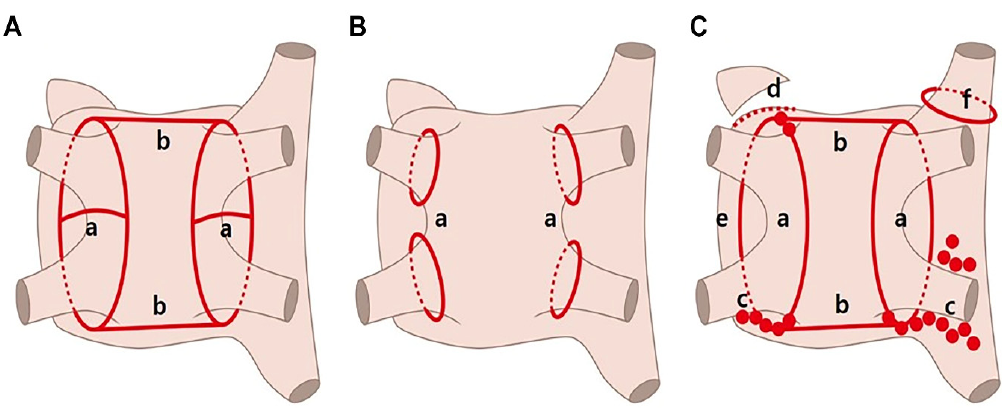
Figure 2. Schematic map of the three procedures. ( A ) Radiofrequency catheter ablation. ( B ) Cryoballoon ablation. ( C ) Totally thoracoscopic ablation. PV, pulmonary vein; GP, ganglionated plexus; LA, left atrium; SVC, superior vena cava. a, PV isolation. b, Roof and posterior line ablation; c, GP ablation; d, LA auricle resection; e, Division of Marshall vein; f, SVC ablation.